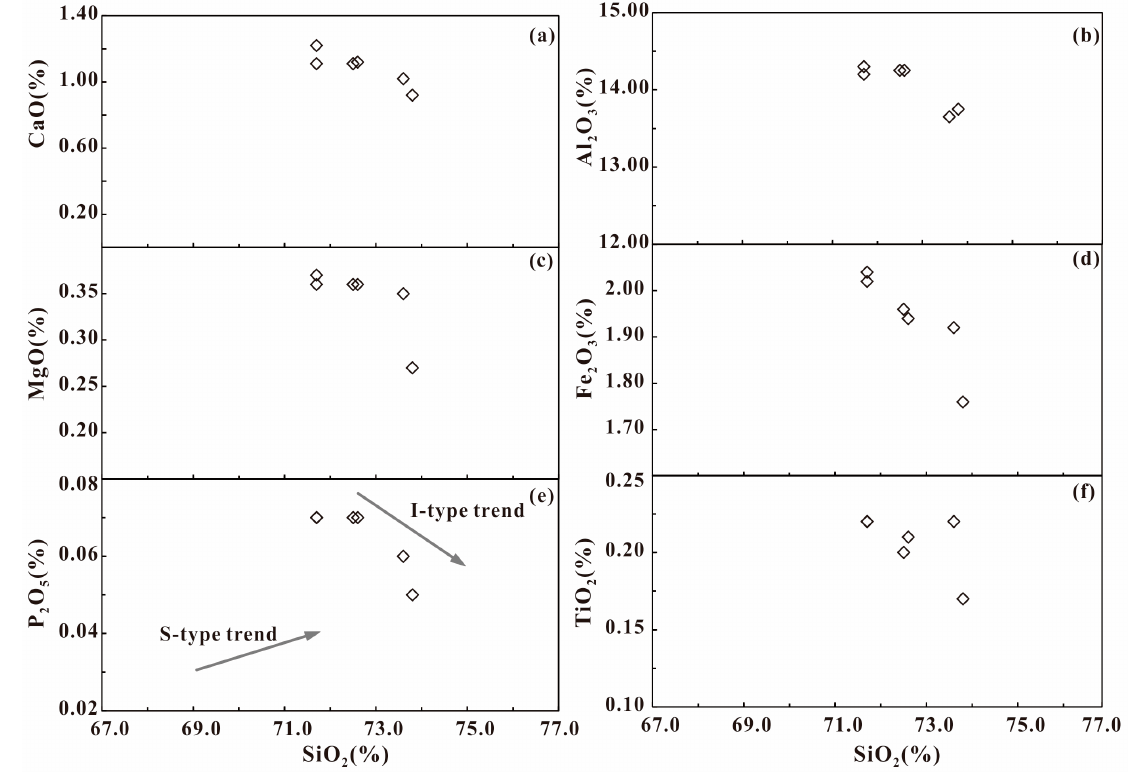
Figure 6. Harker diagrams of major elements for the MG from the Wulandele Mo deposit: ( a ) CaO vs. SiO 2 ; ( b )Al 2 O 3 vs. SiO 2 ; ( c ) MgO vs. SiO 2 ; ( d ) Fe 2 O 3 vs. SiO 2 ; ( e ) P 2 O 5 vs. SiO 2 ; ( f ) TiO 2 vs. SiO 2 .